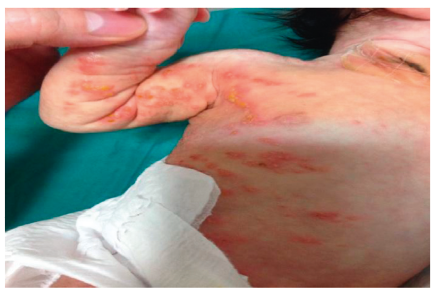
Figure 2: The appearance of skin lesions on the trunk and upper extremity of the patient.